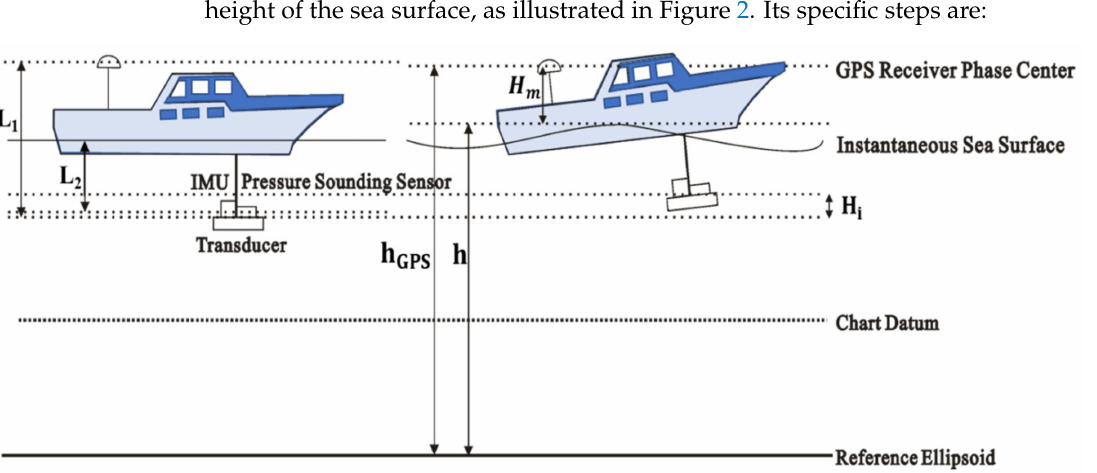
Figure 2. Schematic diagram of the reduction in the sea surface geodetic